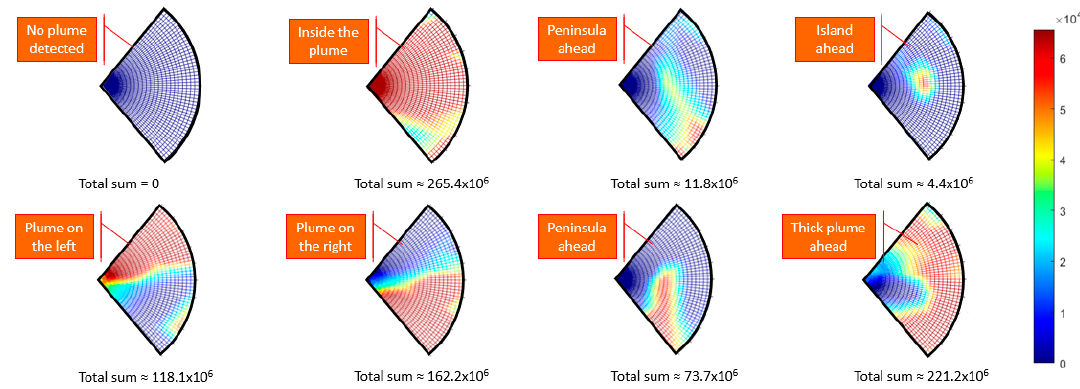
Figure 9. Detection results of the plume edge. They varied in total sum and in the shapes, which define the relation of the AUV to the plume. They are useful for making decisions on the next AUV heading. Sensed plume shapes are named as Empty, Full, Thin-peninsula, Island, Left-side, Right-side, Thick-peninsula, Plume-ahead (from left to right).